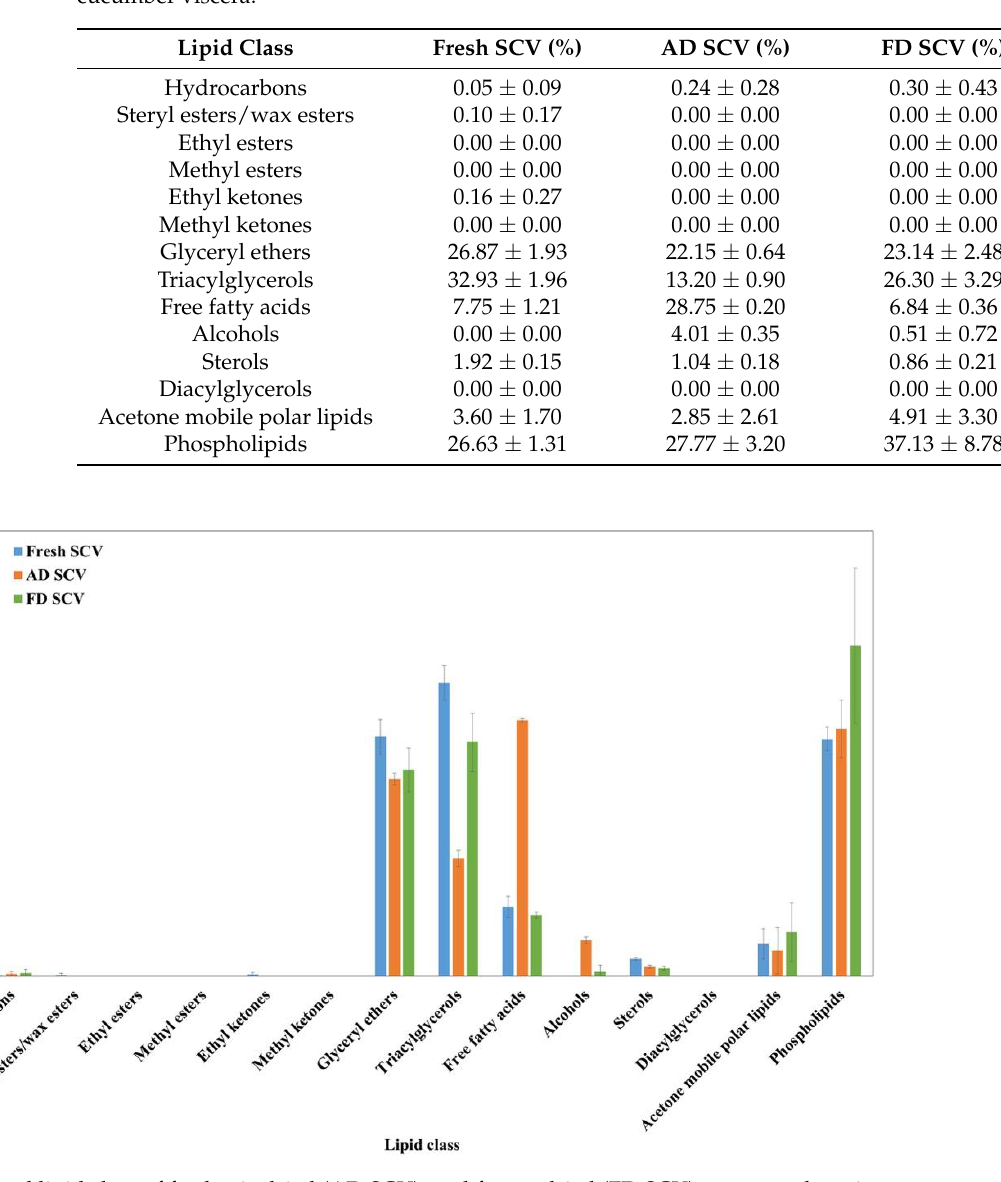
Figure 5. Total lipid class of fresh, air-dried (AD SCV), and freeze-dried (FD SCV) sea cucumber viscera.